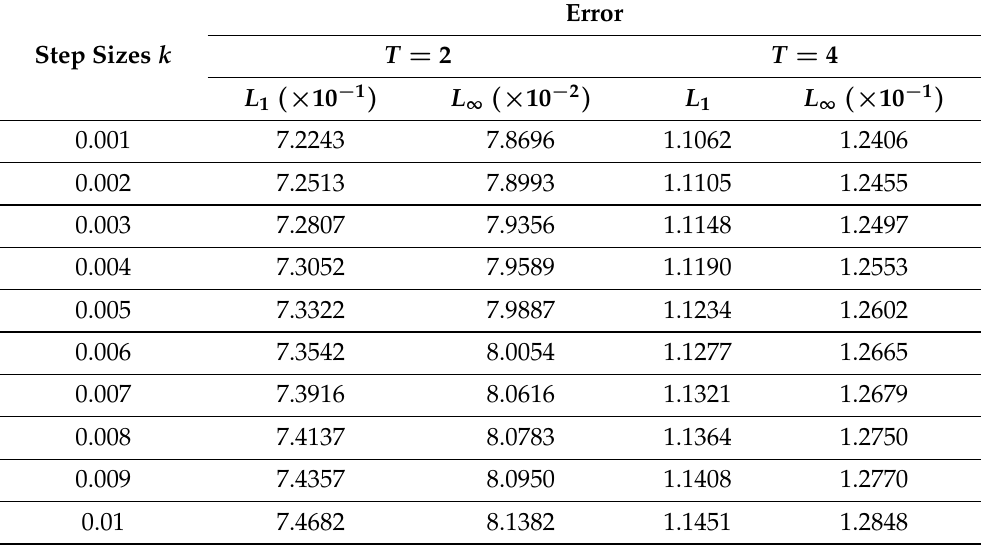
Table 3. L 1 and L ∞ errors for various k when h = π /10 when Scheme 3 is employed to approximate Numerical Experiment 1 at T = 2 and T = 4.